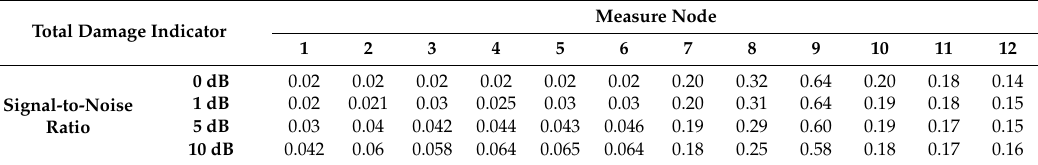
Table 8. Results comparison based on signals with di ff erent levels of